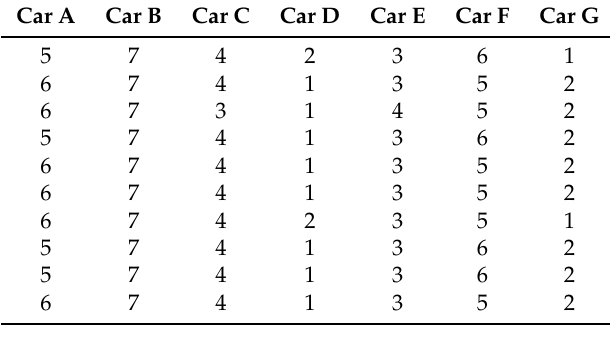
Table 6. Some ranking orders of the seven types of cars with K = 100.